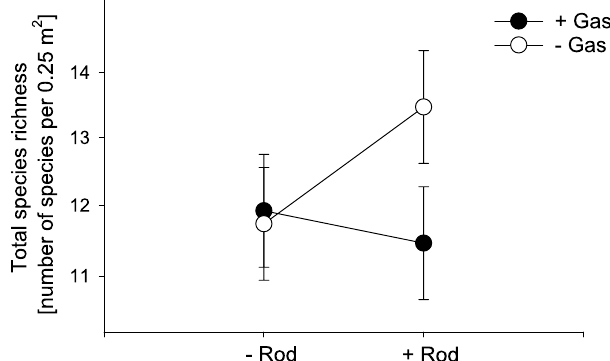
Figure 4. Effect of gastropod herbivory ( + Gas = gastropod control, − Gas = gastropod exclusion) and rodent herbivory ( + Rod = rodent control, − Rod = rodent exclosure) on total species richness (including resident and sown species). Data shown are least square means of repeated-measure linear mixed models ± SE averaged across two years. Note that species richness is given on a square root scale.